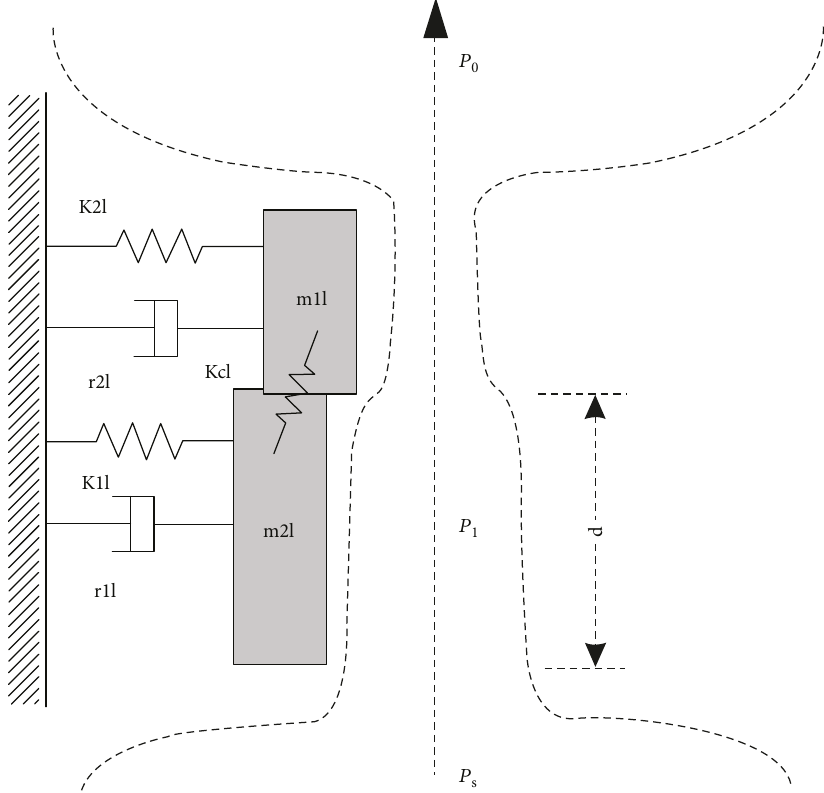
Figure 1: Schematic of the Herzel and Steinecke